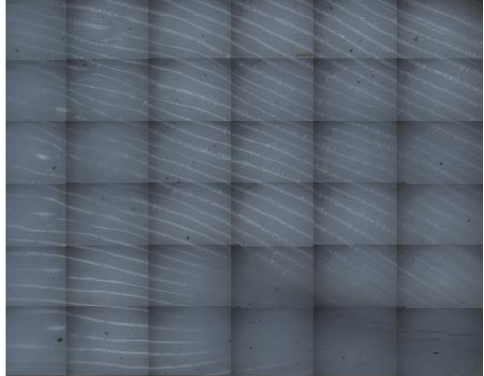
Figure 18. Compressed raster distortion map.